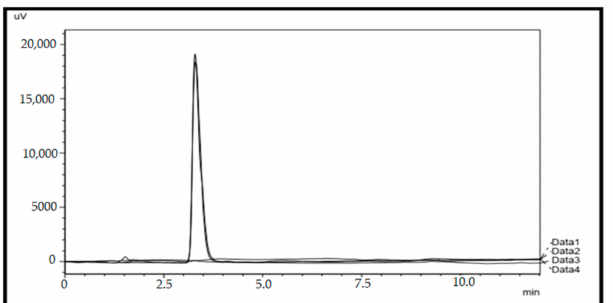
Figure 1. Chromatograms of blank (Data 1), placebo (Data 2), standard (Data 3), and sample (Data 4).